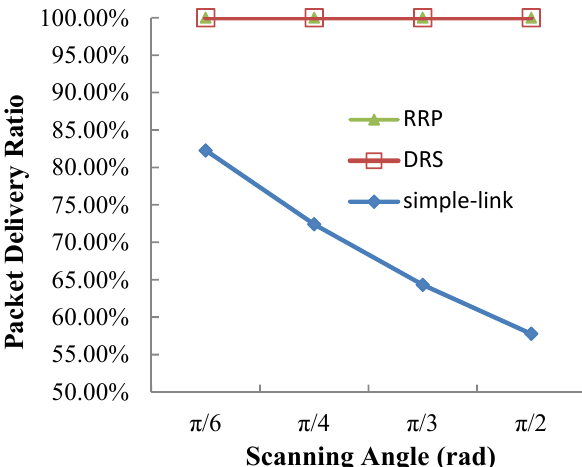
Figure 12. Packet delivery ratio vs. scanning